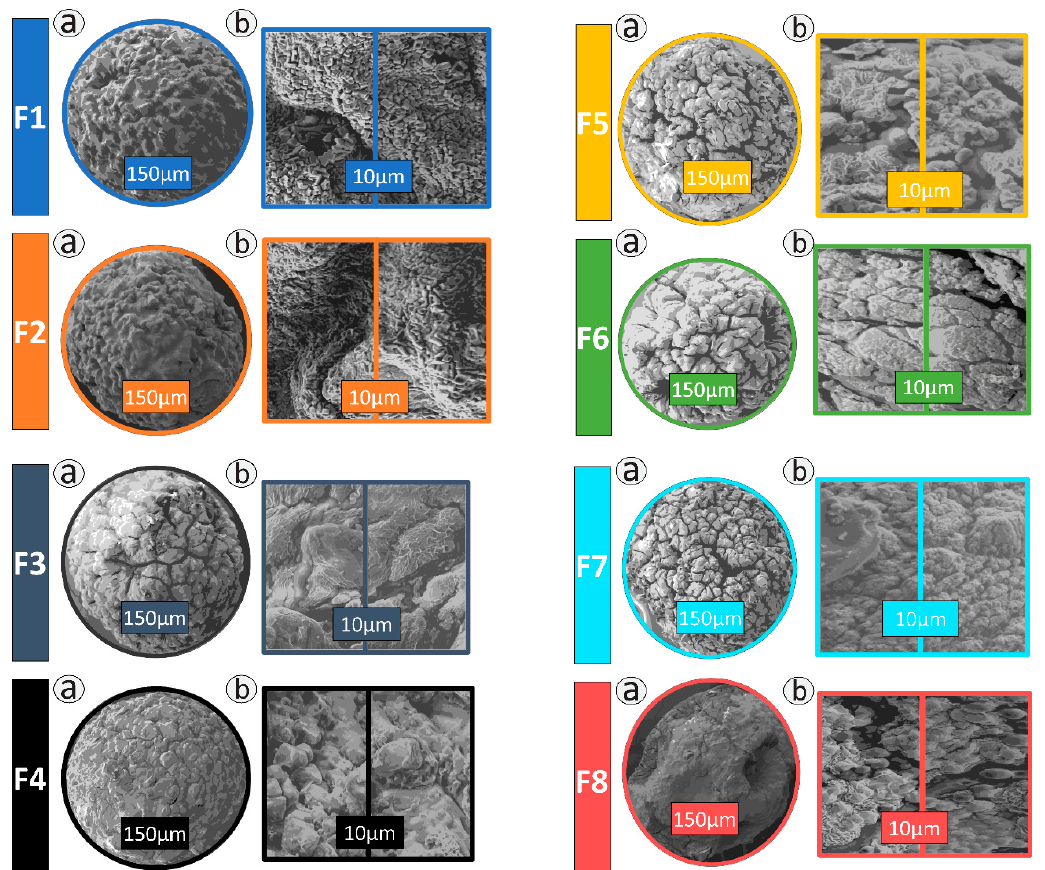
Figure 1. Topography and sizing of encapsulated cells by SEM for F1–F8 at magnifications of 150 μ m and 10 μ m.